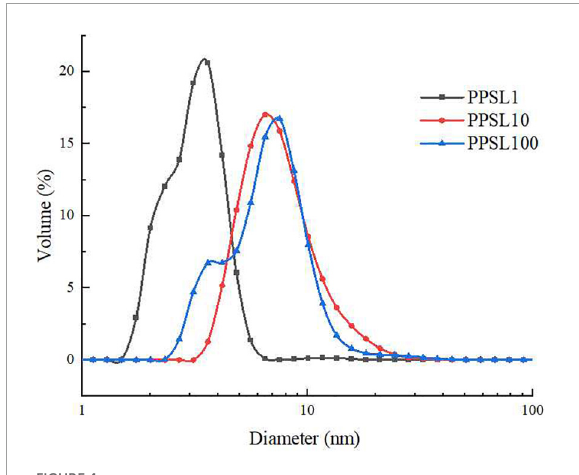
FIGURE4 Particle size diagram of PPSL1, PPSL10, and PPSL100.